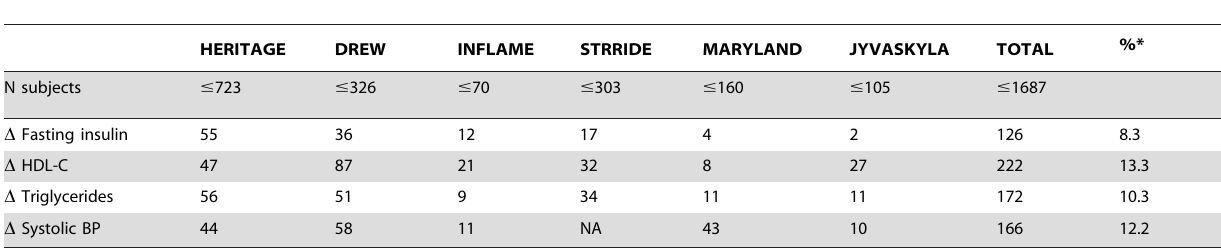
Table 5. Prevalence of Adverse Responders to Regular Exercise in Six